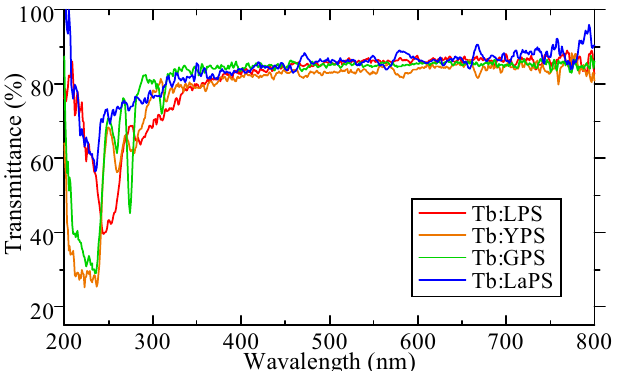
Figure 3. Diffused transmittance spectra of Tb-doped LPS, YPS, GPS, and LaPS samples.